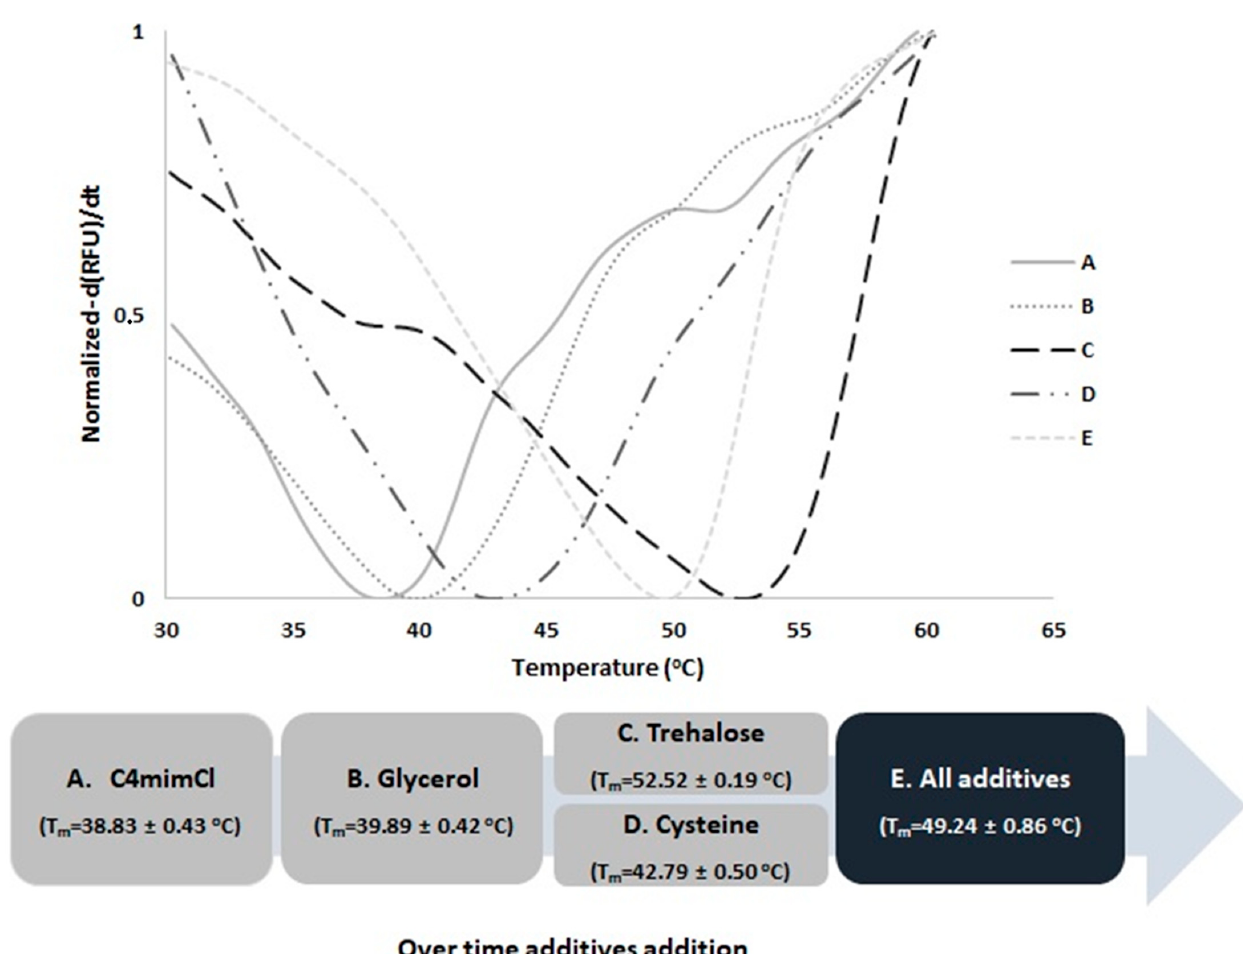
Figure 5. Graphical representation of hSCOMTVal108 normalized first derivate — (dRFU)/dt vs. temperature in the presence of: A. 10 mM Tris-HCl and 0.5 M [C 4 mim]Cl; B. Buffer A and 30% glycerol; C. Buffer B and 150 mM trehalose; D. Buffer B and 100 mM cysteine; E. Buffer A and 150 mM trehalose, 100 mM cysteine and 30% glycerol.